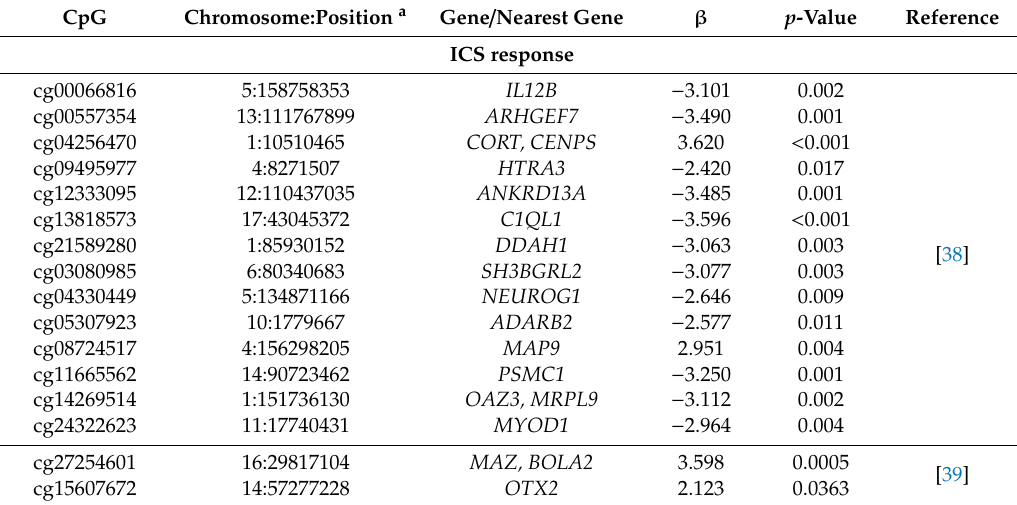
Table 2. Summary of the main recent findings of epigenomic studies focused on DNAm in childhood